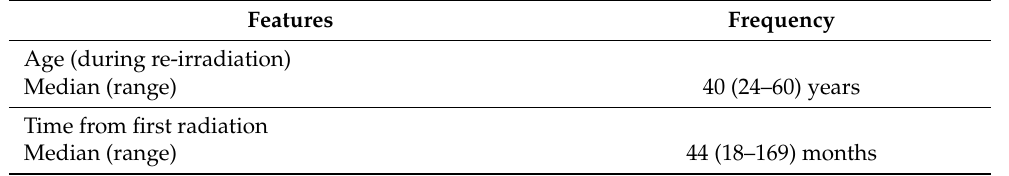
Table 2. Clinical characteristics during recurrence and details of